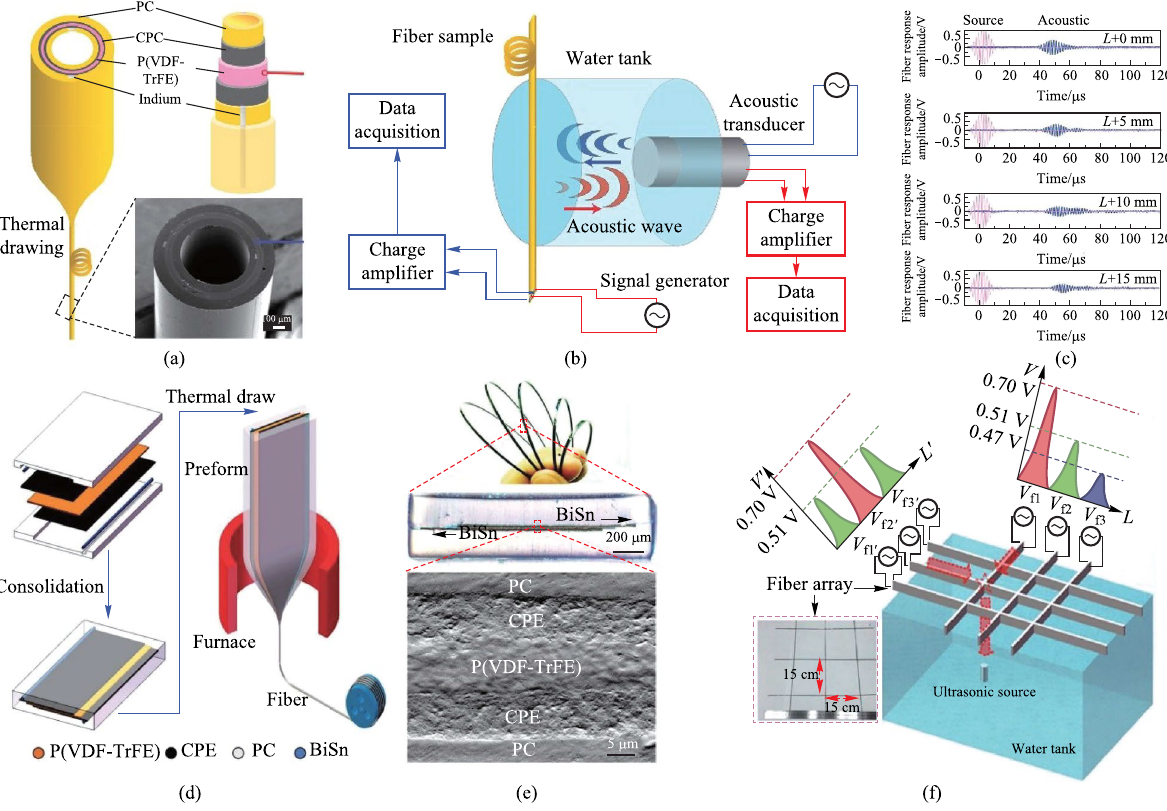
Fig. 6 Thermally-drawn piezoelectric fibers for aquatic acoustic sensing and positioning. a Structure of a cylindrical TDPF for acoustic sensing. b Experimental set-up for acoustic characterization of piezoelectric fibers. An acoustic wave travels across a water tank from a water-immersion acoustic transducer to a fiber sample, and vice versa. c Temporal traces of electrically amplified acoustic signals detected by a piezoelectric fiber, shown together with the excitation signals. d Schematic diagram of the fabrication process of a rectangular TPDF for acoustic sensing. e Digital photo, optical microscope image, and the cross-section SEM image of the rectangular TDPF. f Schematic of an acoustic sensor network based on a 3 × 3 piezoelectric fiber array for underwater acoustic positioning. Reprinted with permission from Refs. [55,